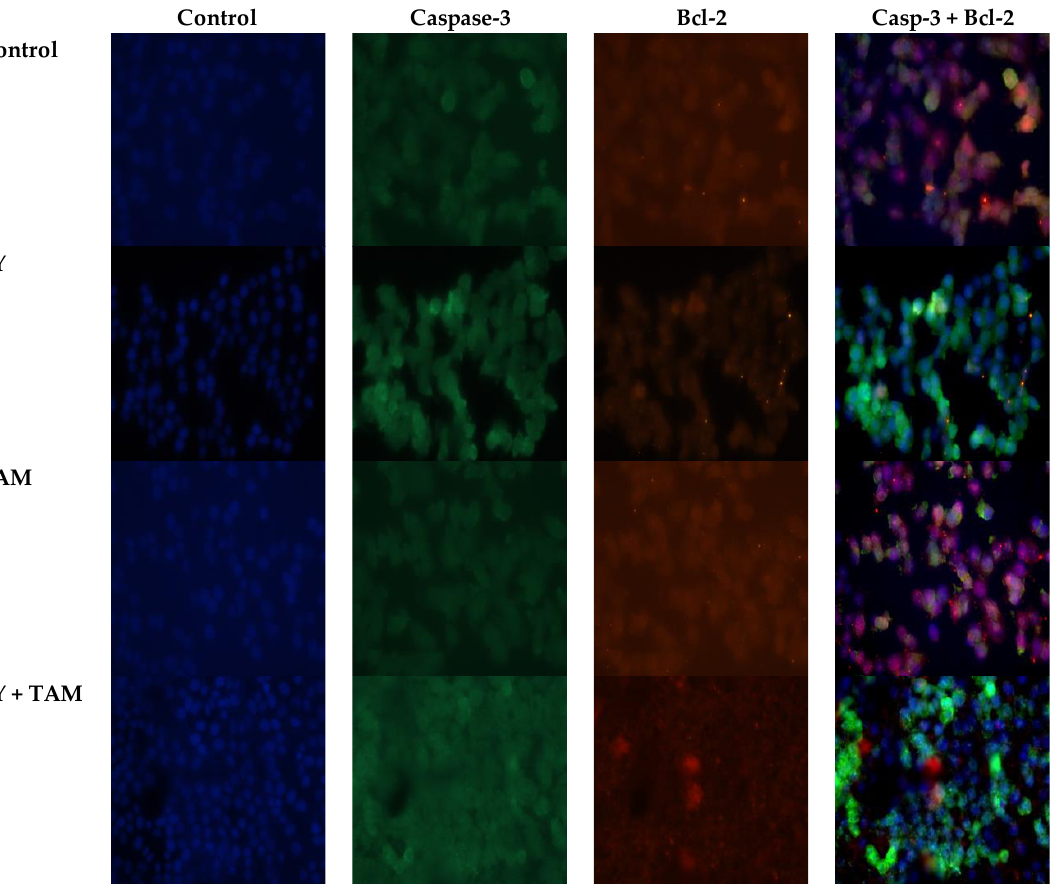
Figure 4. The induction of apoptosis in MCF-7 cells treated with LY, TAM, and LY + TAM combination 24 h. Images taken with confocal microscope (EVOS FL, scale bar 20 nM) to evaluate the expression of apoptotic (Caspase-3) and antiapoptotic (Bcl-2) markers. The images show green and red color staining for Caspase-3 and Bcl-2, respectively. Overlay images represent the fluorescence intensity of both apoptotic markers.